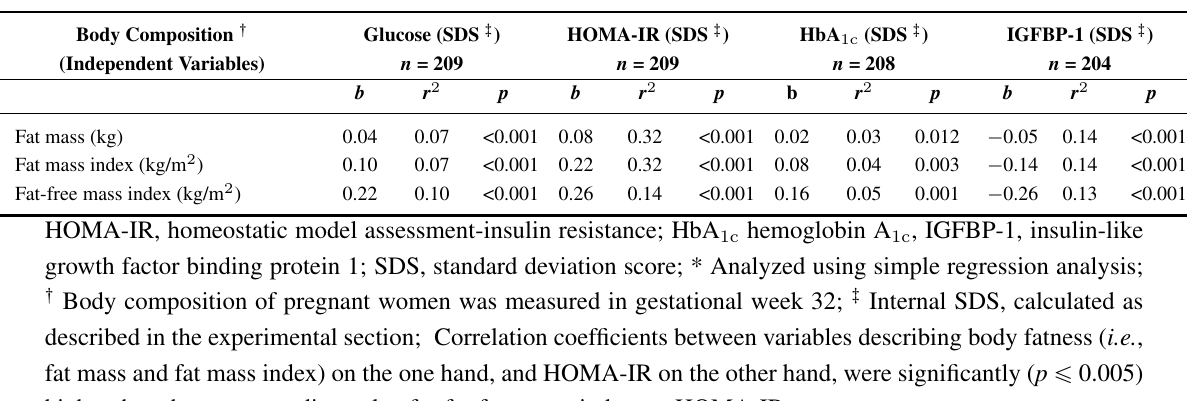
Table 2. Glucose homeostasis variables (glucose, HOMA-IR, HbA circulation of women, pregnant in gestational week 32, regressed on variables describing their body composition (fat mass, fat mass index and fat-free mass index).